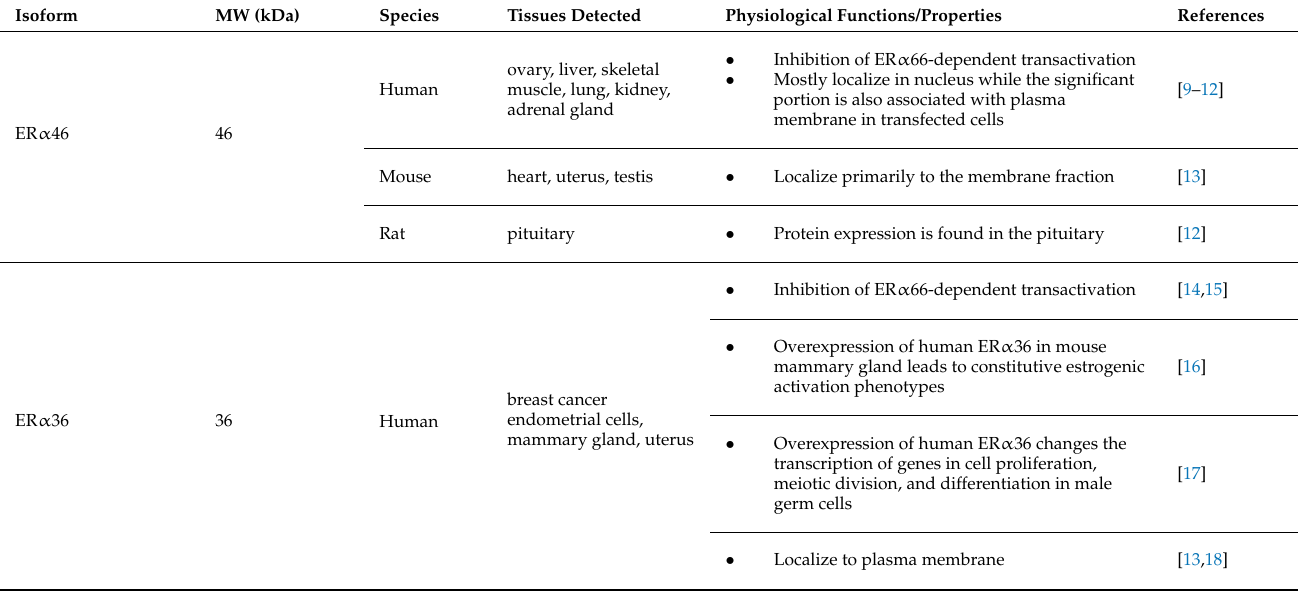
Table 1. ER α alternative splicing variants and their physiological functions and/or